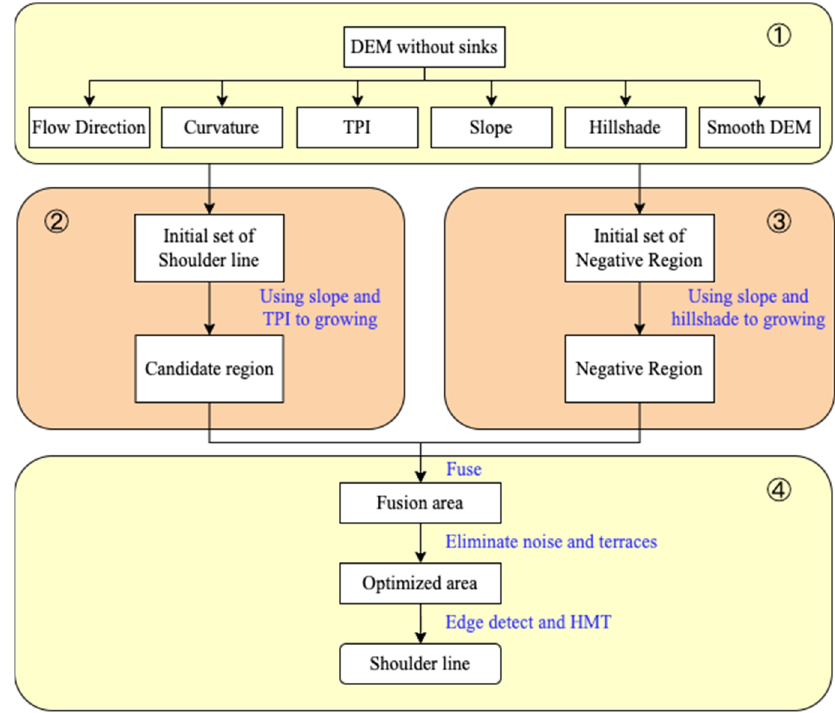
Figure 4. Flowchart of the proposed extraction method of loess shoulder-lines.